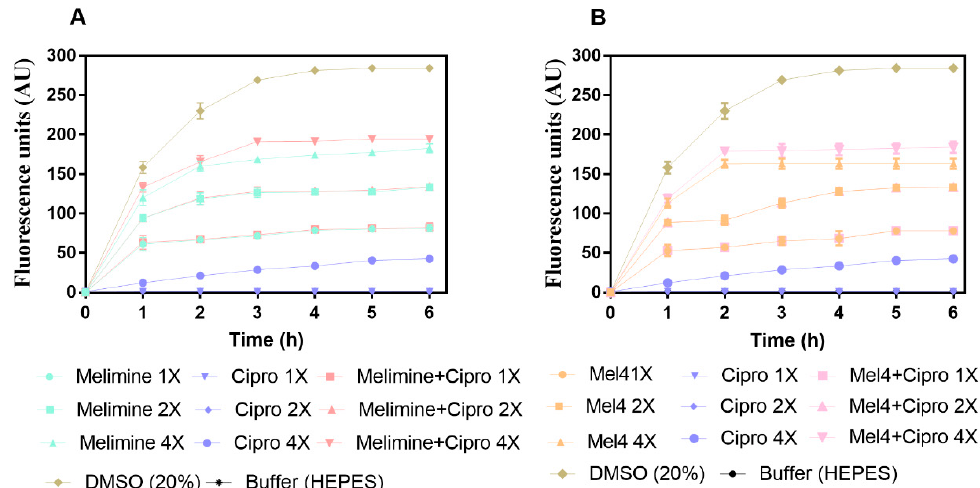
Figure 6. Cell membrane depolarization of pre-formed (24 h) biofilm cells. Cell membrane depolarization of P. aeruginosa ATCC 27853 ( A ) by melimine and ciprofloxacin alone or in combination, and ( B ) by Mel4 and ciprofloxacin alone or in combination against pre-formed (24 h) biofilms. Means ( ± SD) of three independent repeats in triplicate. Cipro = ciprofloxacin, DMSO = dimethyl sulfoxide.